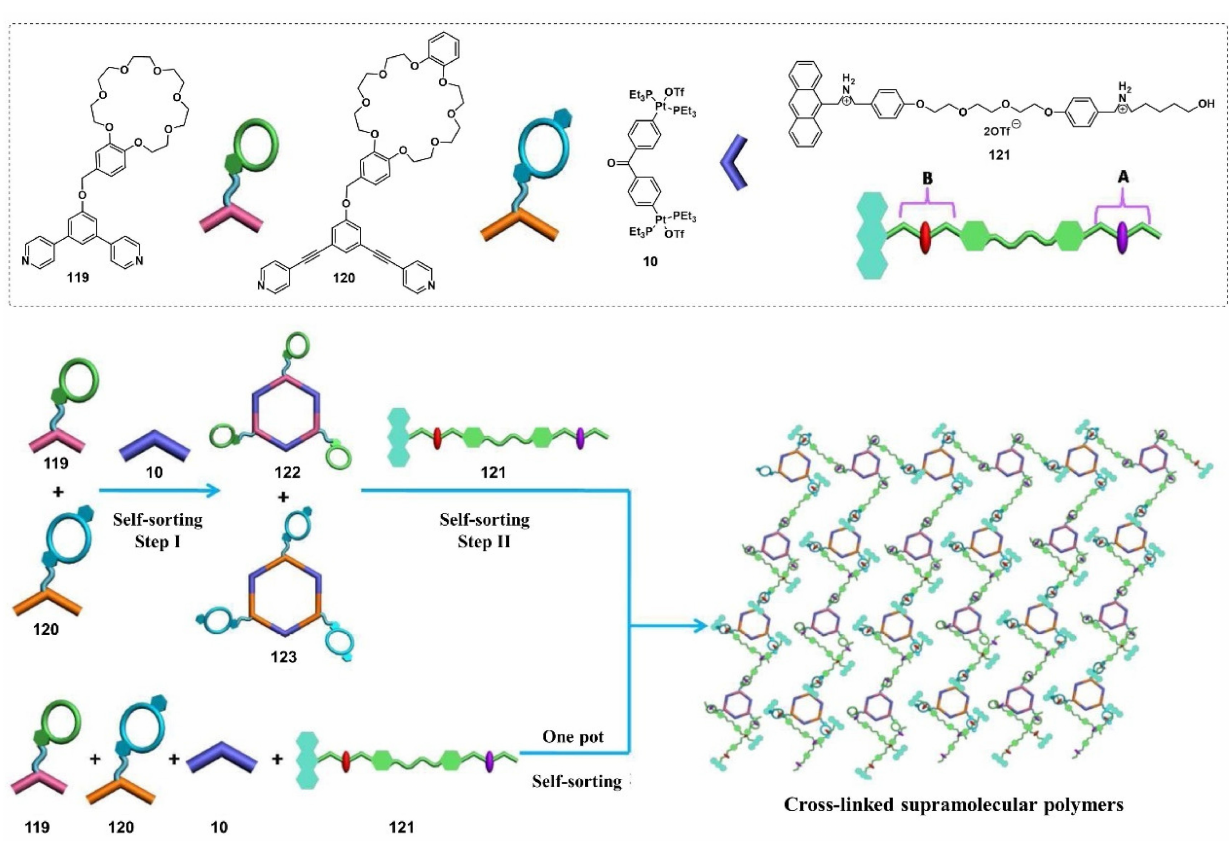
Figure 50. Schematic representation of the construction of cross-linked supramolecular polymers from monomers 119 – 121 and 10 through the stepwise approach (top) and the one-pot approach (bottom). Reprinted with permission from Ref. [132]. Copyright (2015), Royal Society of Chemistry.